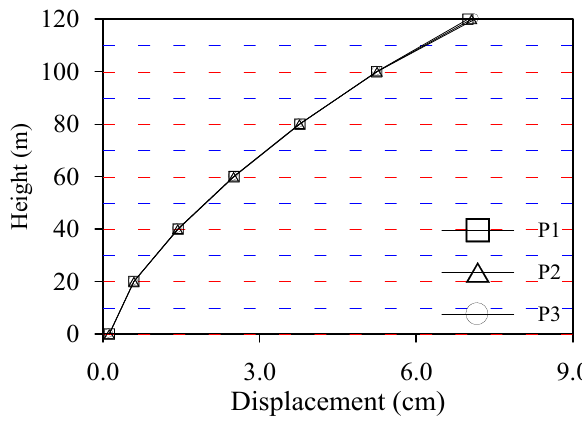
Fig. 11. The variation of maximum displacements on II-II section of the arch dam for Case P.